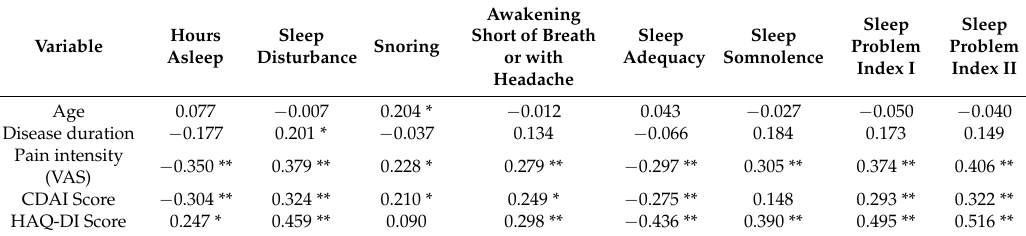
Table 3. Spearman’s rank order correlation of variables that correlate with the sleep domains.